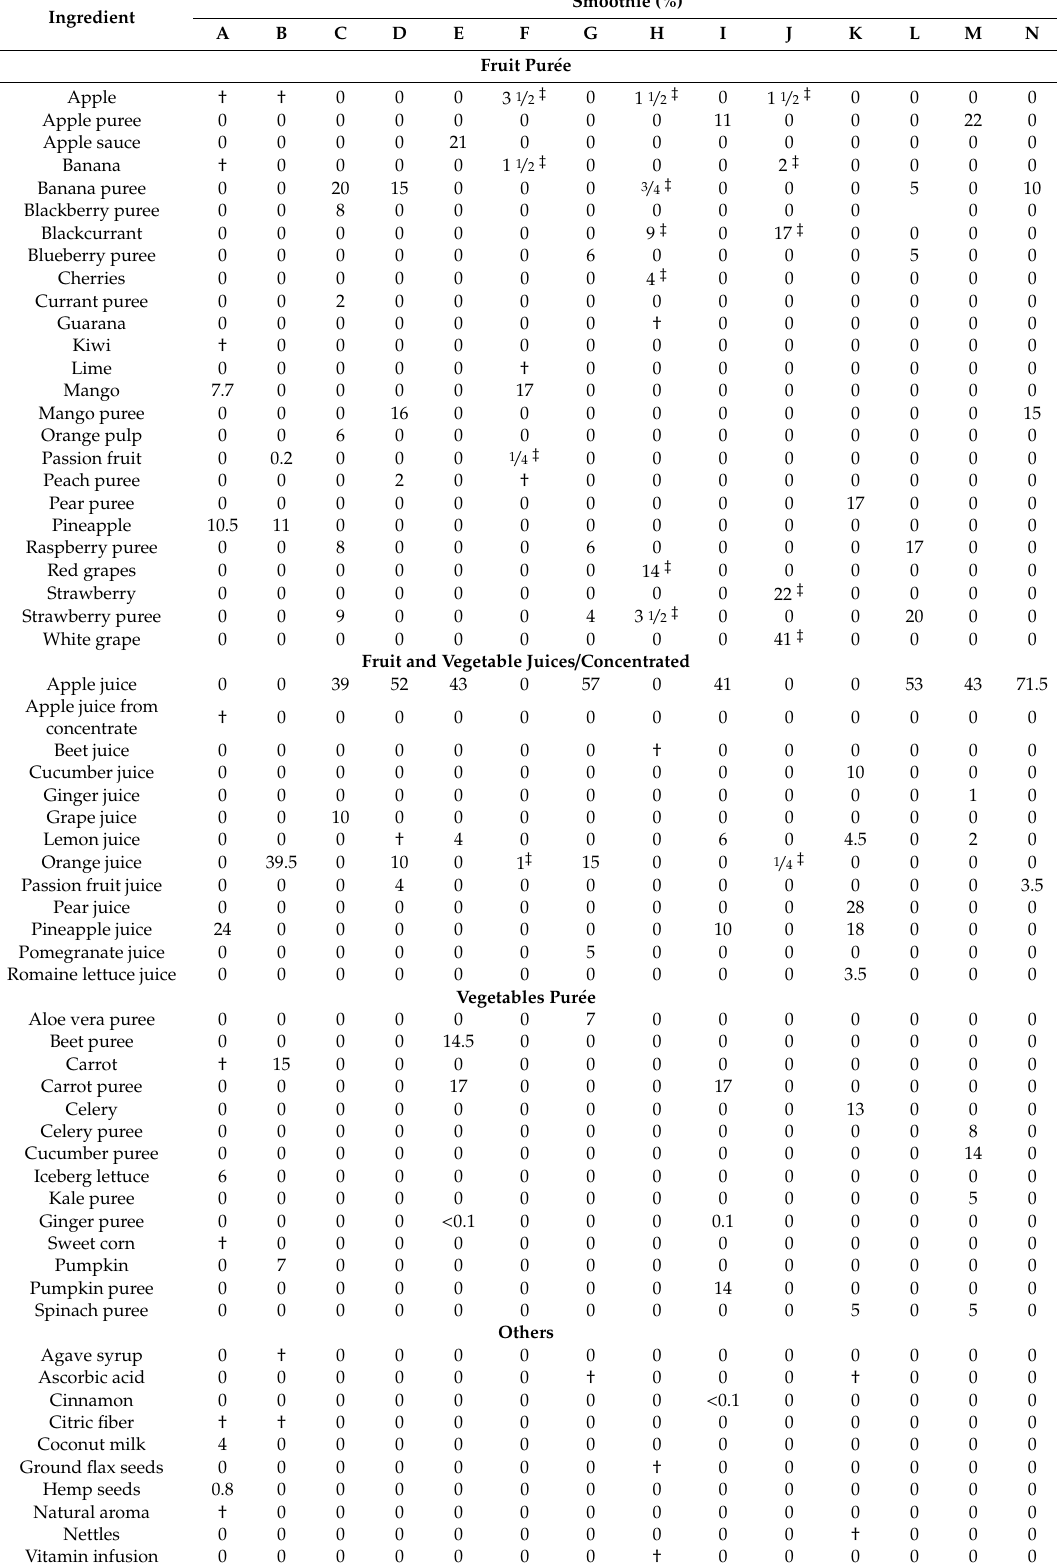
Table 1. Composition of commercial smoothies used in this